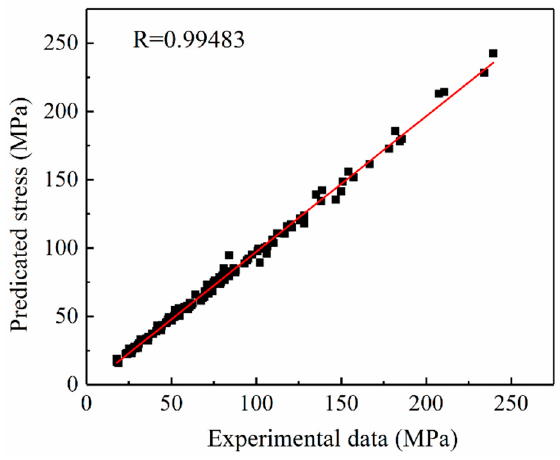
Figure 6. Correlation between the predicted and experimental flow stress results.